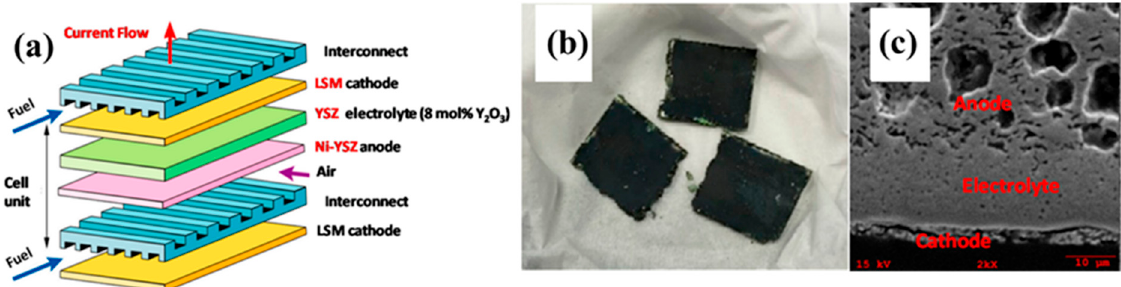
Figure 5. ( a ) Solid oxide fuel cell (SOFC) design architecture. A single cell unit include cathode (LSM), electrolyte (YSZ), and anode (Ni–YSZ), air is supplied to the cathode surface whereas fuel is supplied to the anode surface. ( b ) Complete three-layered cell samples (30 × 30 mm). ( c ) cross- section SEM image of the interfaces for a complete cell sample